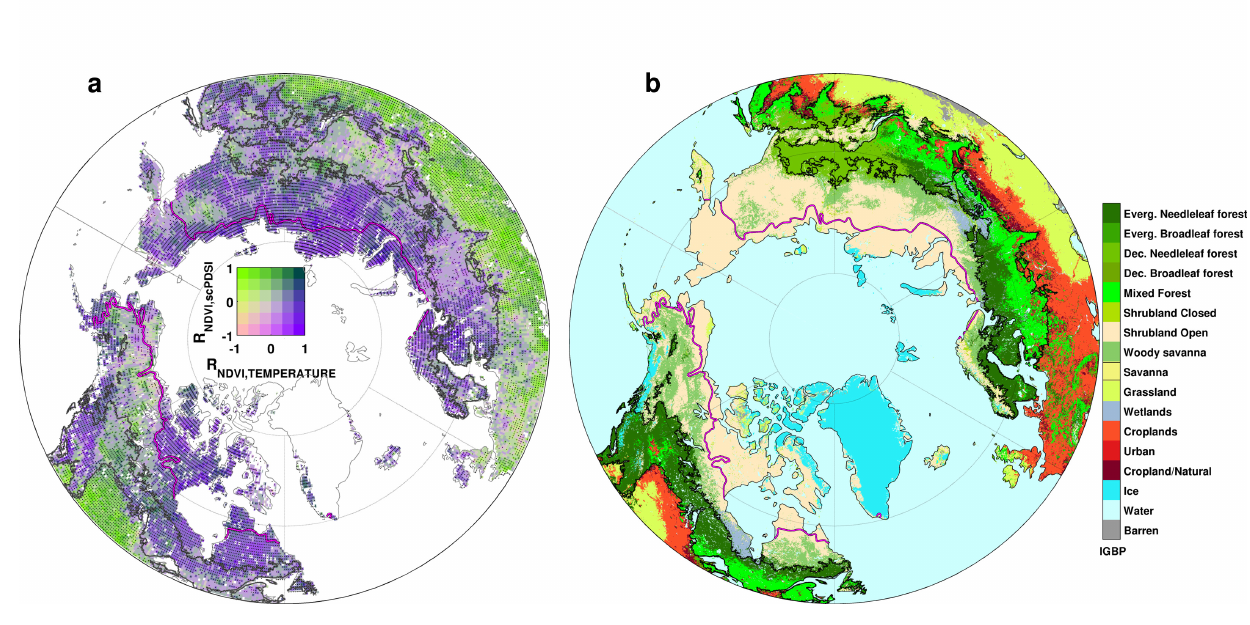
Figure 5. Geography of moisture and temperature controls on summer NDVI at northern latitudes during the last 30 years and relationship with major land cover types. ( a ) Bivariate correlation map between detrended summer (June-August) NDVI and detrended variations in spring-summer (March–August) scPDSI and summer temperature during the period 1982–2009. Light greens indicate a strong moisture limitation ( i.e. , strong positive correlation with precipitation and negative correlation with temperature), whilst purple shades indicate a dominant temperature limitation ( i.e. , strong positive correlation with temperature and weak correlation with precipitation). The stippling indicates grid boxes where either correlations with temperature or scPDSI are statistically significant ( p < 0.1); ( b ) IGBP land cover classification for the study domain. The black polygons in the maps denote the extent of the boreal forests as defined in this study. Also shown is the present position of the latitudinal treeline (purple